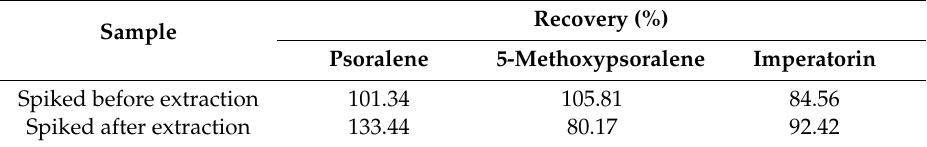
Figure 1. Extraction e ffi ciencies of di ff erent solvents expressed as the normalized concentrations of the analytes. Table 1. Recovery values of the analytes when added to the sample before and after extraction.